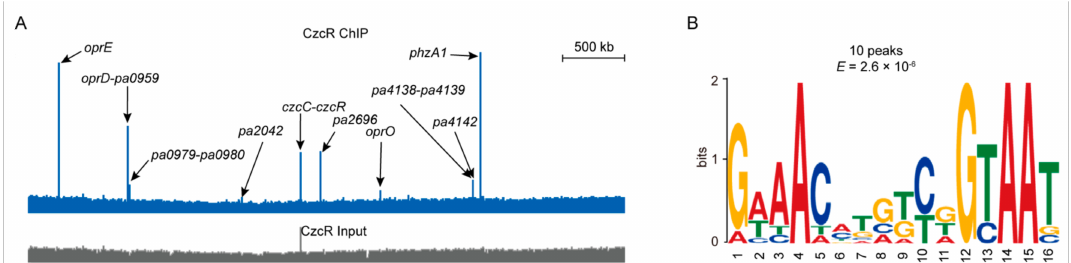
Figure 2. Identification of CzcR targets. ( A ) A representative image of CzcR ChIP-seq result using Integrated Genome Viewer. ChIP sample (blue) and the input control sample (grey) were shown. Arrows showing the ChIP-seq peaks located in the promoters of the indicated genes. ( B ) The most significant motif was generated by the MEME tool using 101 bp centered on the peak summits of the top 10 peak sequences (Data set 1, sheet 8), with minimum width as 3 and other parameters as default. The height of each letter represents the frequency of each base in different positions in the consensus sequence. The 16 nt motif was present in all the 10 tested CzcR binding sites with an E-value of 2.6 × 10 -6